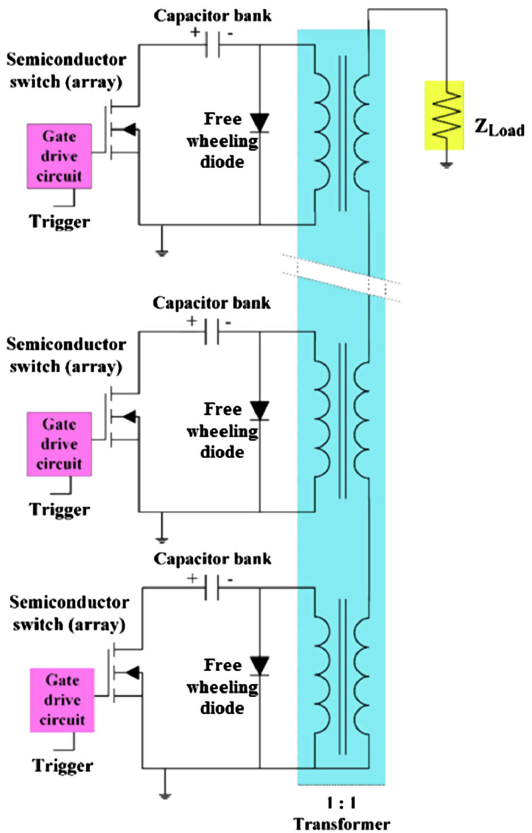
FIG. 2. Simplified schematic of an inductive adder